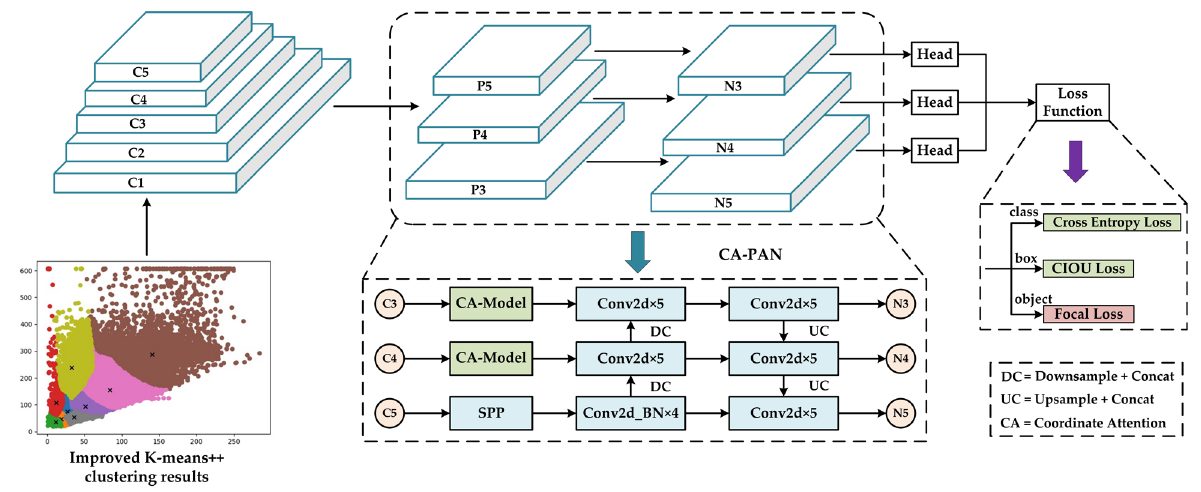
Figure 9. VV -YOLO model structure. Figure 9. VV-YOLO model structure.